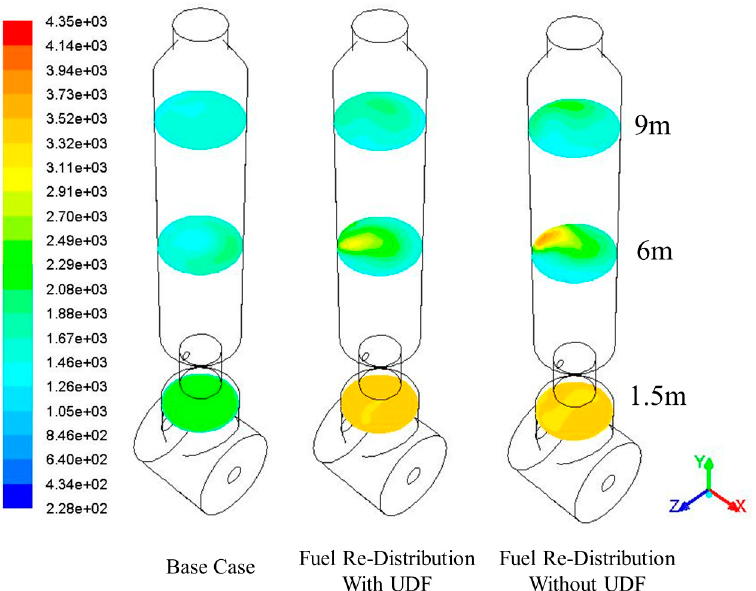
Figure 5. Comparison of temperature distribution on selected height for the case of fuel re-distribution with and without condensation and re-vaporization sub-models.